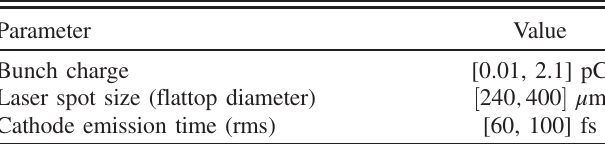
TABLE I. ASTRA input parameter ranges for the dataset production.